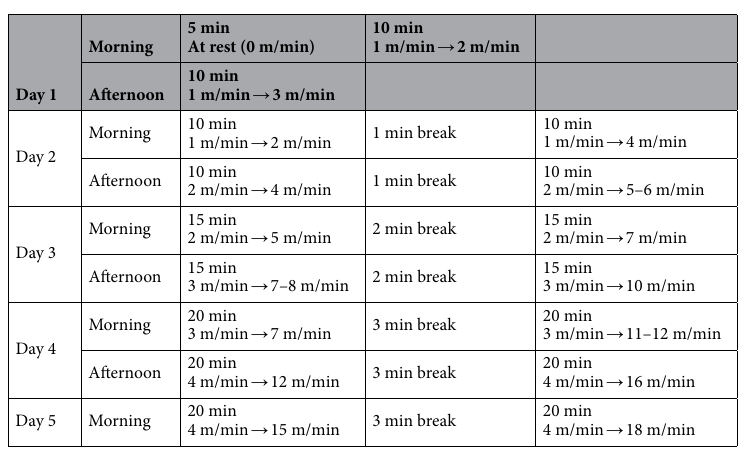
Table 1. Training protocol. During each training session, treadmill speed was gradually increased up to the maximum speed mentioned. From Day 2, each training session included two running blocks with 1–3 min break in